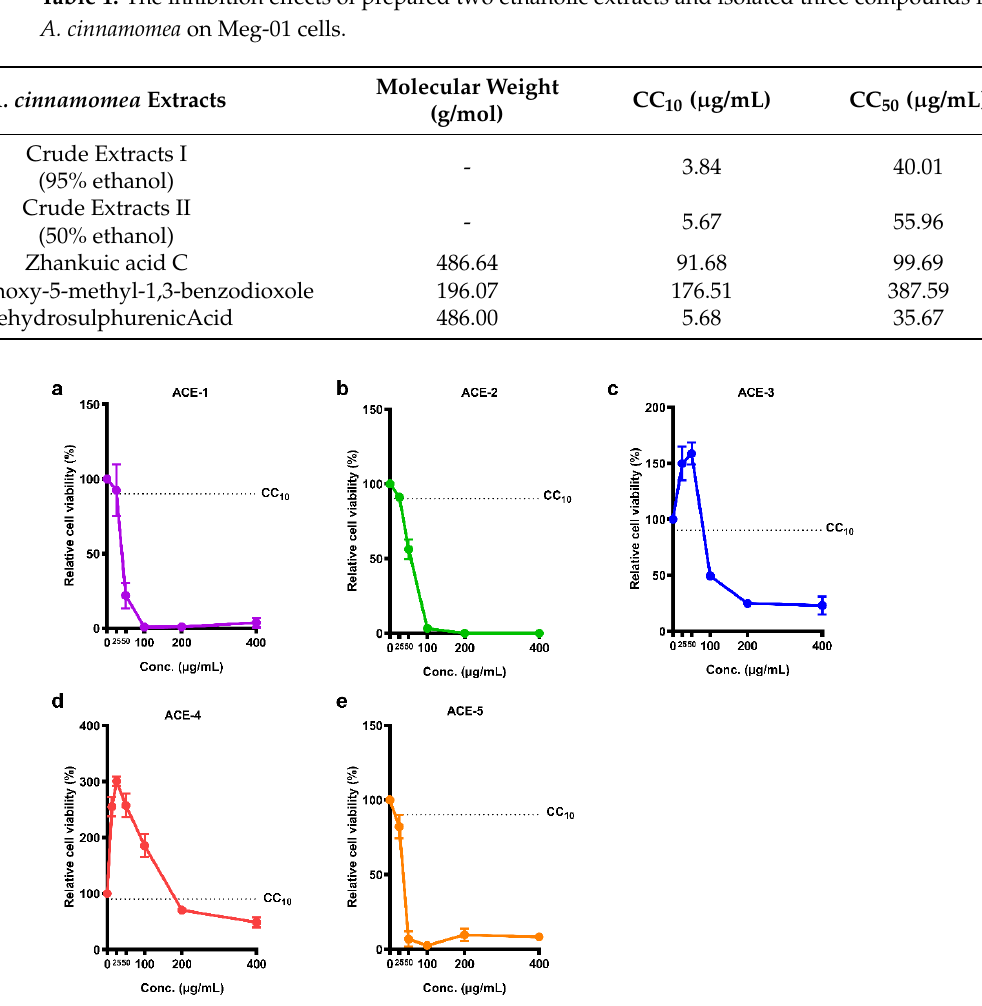
Figure 1. Cell viability of the five A. cinnamomea extracts in Meg-01 cells. Meg-01 cells were cultured with different concentrations of A. cinnamomea extracts, ( a ) ACE-1, ( b ) ACE-2, ( c ) ACE-3, ( d ) ACE-4, and ( e ) ACE-5, for 24 hours followed by reacting with WST-1 reagent. All the values represent as mean ± SEM of three experiments. The dotted line represents the value of CC 10 . 2.2. Inhibitory Effects of the A. cinnamomea Extracts Against DENV Meg-01 cells were treated with different A. cinnamomea extracts after DENV infec- tion, and the viral titers of DENV were evaluated using a plaque assay (Figure 2).The concentrations of ACE-1 – ACE-5 were used in viral titer, which are 3.84, 5.67, 91.68, 176.51, 5.68 μg/mL ,respectively.The replication curve for DENV in Meg-01 cells was calculated. The viral titer peak was observed on day 5 post-infection and remained steady until day 7 (Figure 2a). The antiviral effects of A. cinnamomea extracts on DENV were determined by performing a plaque assay with the supernatants collected on dif- ferent days post-infection. From the results, it was observed that the viral titers of DENV decreased in both ACE-3 and ACE-4 treatments during DENV infection as of day 2. Moreover, a significant reduction in DENV resulting from ACE-3 and ACE-4 treatments was also observed at days 5 and 7 post-infection (Figure 2b). Although there was a visible decrease in the viral titer of DENV at 24 h after DENV infection in ACE-1, ACE-2, and ACE-3 treatments, the difference was not statistically significant.